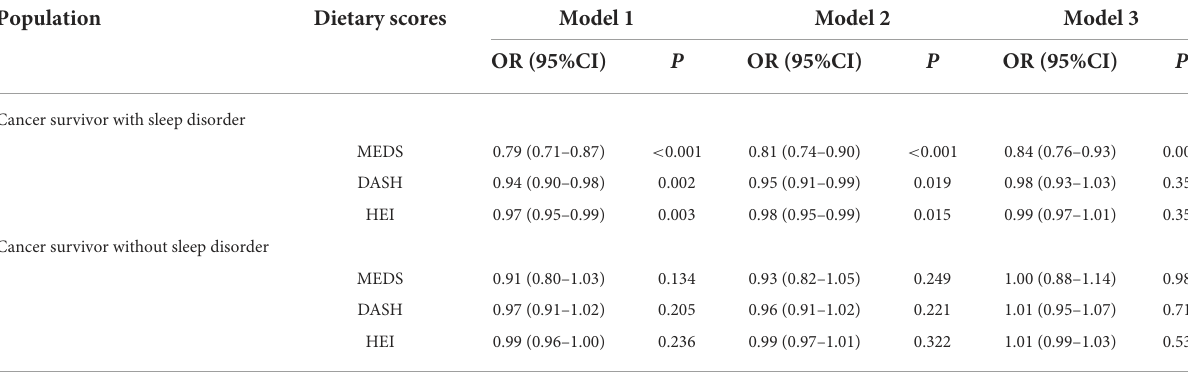
TABLE 3 Association analysis of dietary scores MEDS, DASH, HEI2015, and depression in sleep disorder subgroup.